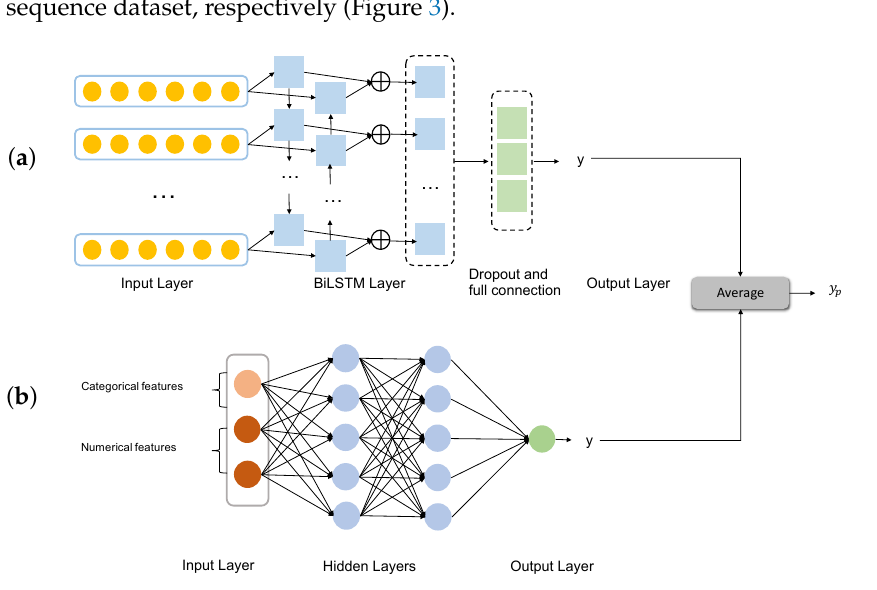
Figure 3. Ensemble deep learning model. ( a ) The MLP is trained on the structured dataset. ( b ) The Bi-LSTM model is trained on the sequence dataset. The two models are stacked in the prediction